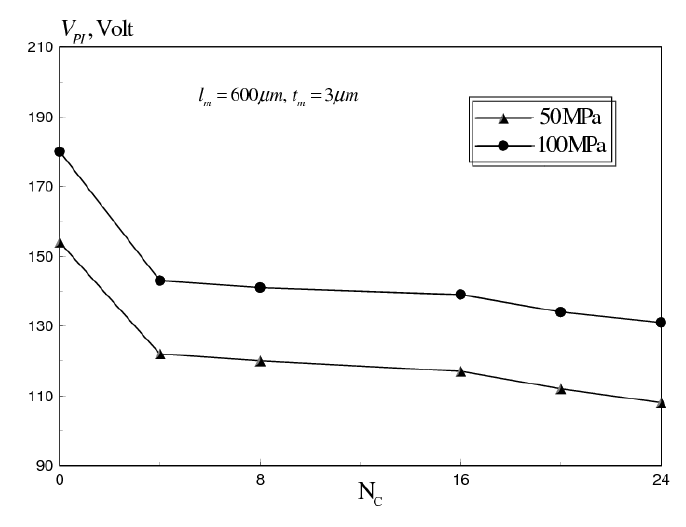
Figure 13. Effect of number of corrugations on V switch at σ ω = 30 GHz).